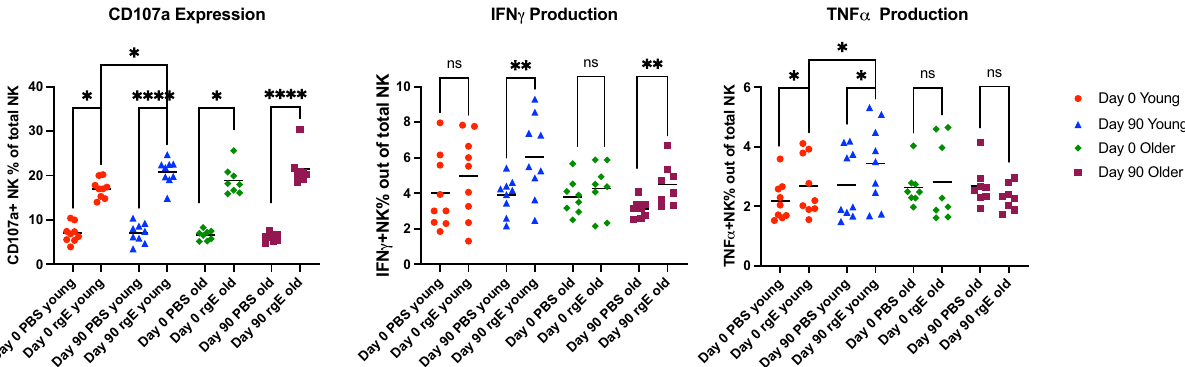
Fig. 5 NK Functionality after Binding to gE-Speci fi c Antibodies in RZV Recipients. Data were derived from 9 young and 8 older RZV recipients. Graphs show proportions of NK cells expressing the marker indicated in the title of each panel. Bars represent medians and quartiles. Signi fi cant differences are shown on the graph and marked by *0.01 < p < 0.05; **0.001 < p < 0.01; or *** p <